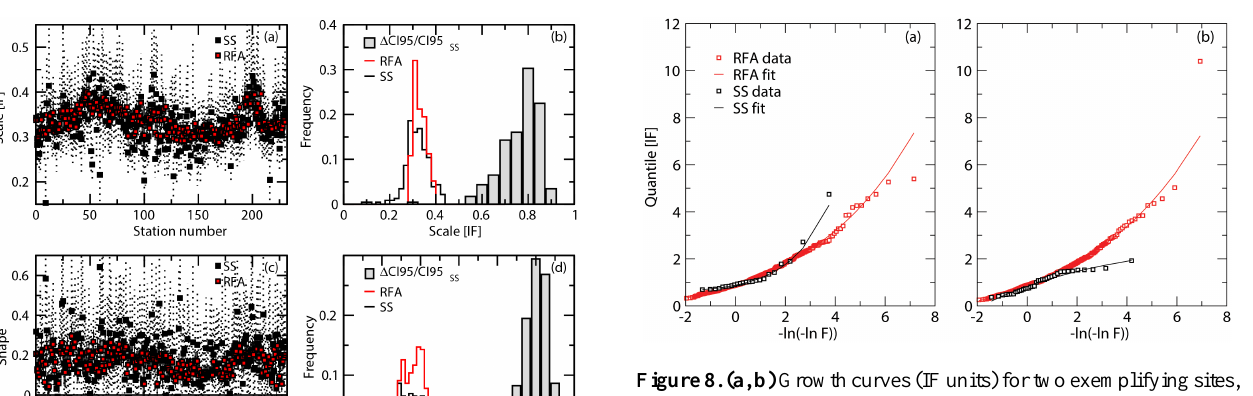
Figure 8. (a, b) Growth curves (IF units) for two exemplifying sites, with SS best guess value of the shape; (a) 0.58 (Diga Ragoleto) and (b) − 0.19 (Sigonella). The relative frequency F on the abscissa is defined according to the Gringorten rule (Gringorten,